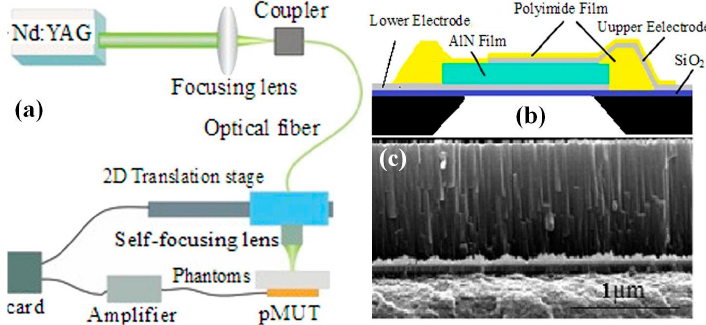
Figure 23. AlN-based piezoelectric micromachined ultrasonic transducer (PMUT) for photoacoustic imaging: ( a ) schematic drawing of the PMUT based photoacoustic imaging system; ( b ) schematic drawing of the thin film AlN based PMUT device; and ( c ) SEM image of the AlN thin film on bottom electrode, scale bar 1 µ m (Reproduced with permission from AIP [121]).